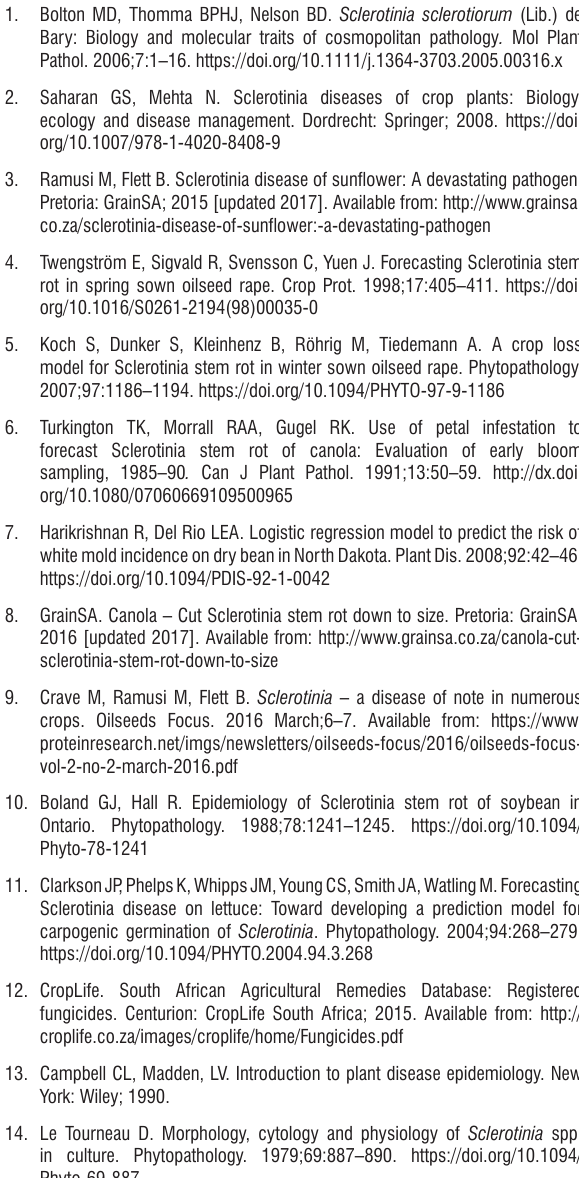
Figure 1: Functional scheme of steps and components included in the forecasting procedure of SkleroPro from Koch et al.